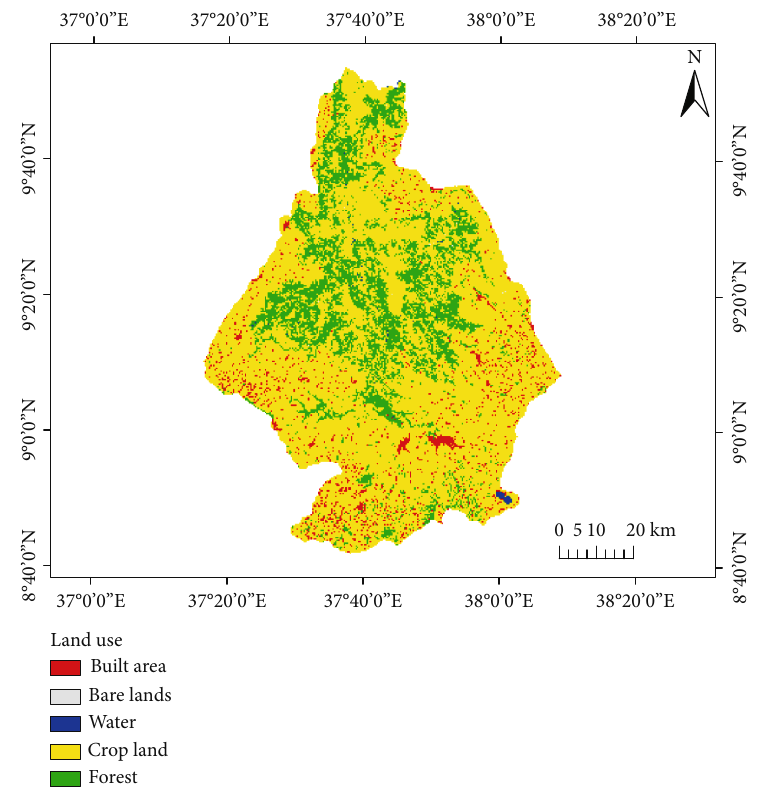
Figure 8: Land use of the Guder watershed.